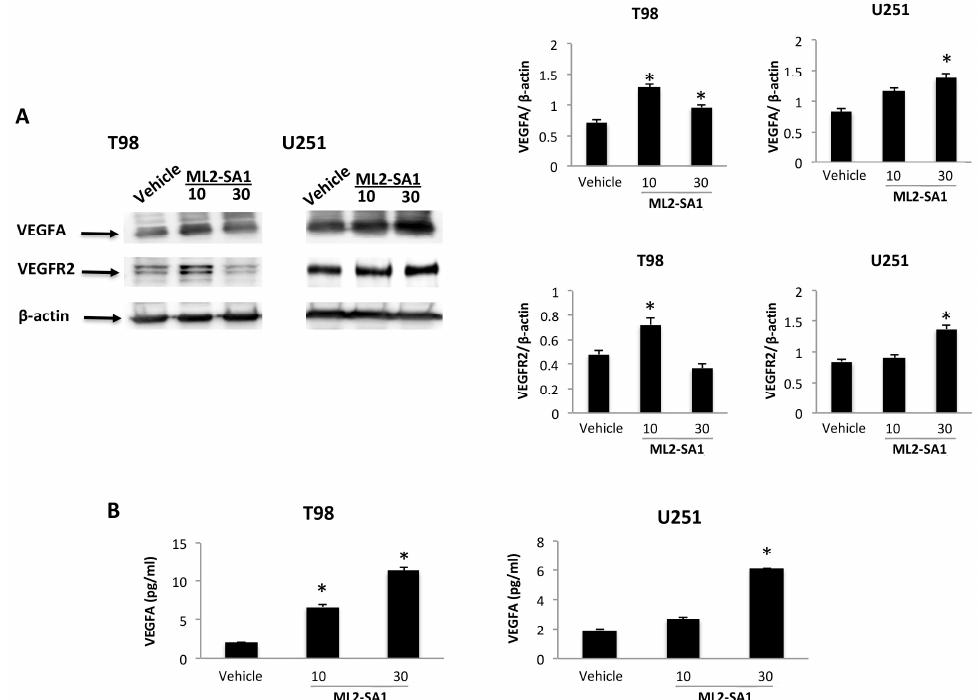
Figure 2. ML2-SA1 improves VEGFA and VEGFR2 proteins expression and increases VEGFA release in T98 and U251 cell lines. ( A ) Representative immunoblots reflecting VEGFA and VEGFR2 protein levels in vehicle- and ML2-SA1 (10 and 30 μ M)-treated T98 and U251 cell lines. Blots are representative of one of three separate experiments. Densitometry values were normalized to β -actin, which was used as a loading control. Data are expressed as the mean ± SE of three separate experiments. * p < 0.05. ( B ) Levels of VEGFA release measured by ELISA were evaluated at 24 h in vehicle- and ML2-SA1 (10 and 30 μ M)-treated T98 and U251 cell lines. Data are expressed as the